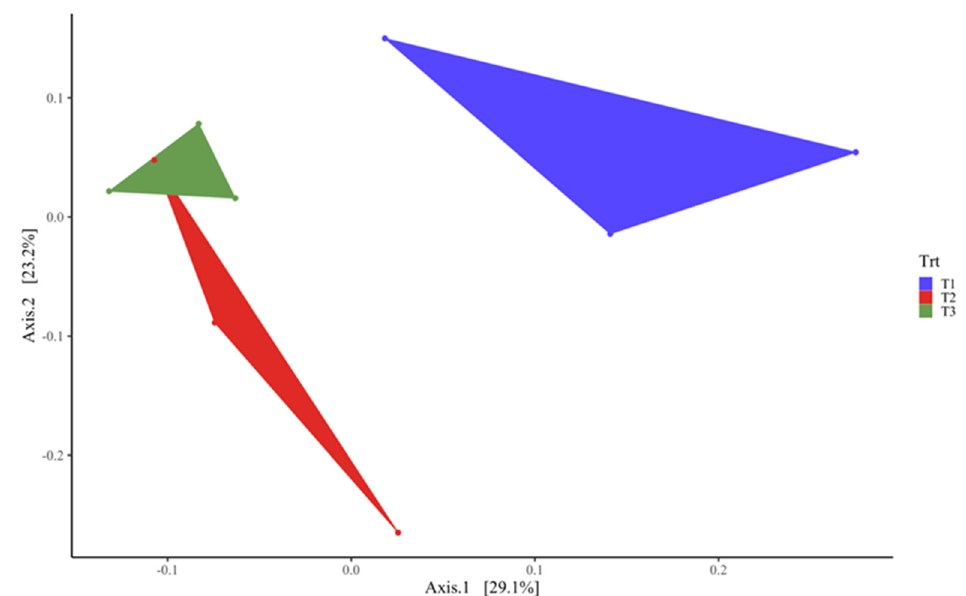
Figure 3. Principal coordinate analysis (PCoA) showing the differences in the bacterial community of meat-master lambs as influenced by sprouts supplementation.